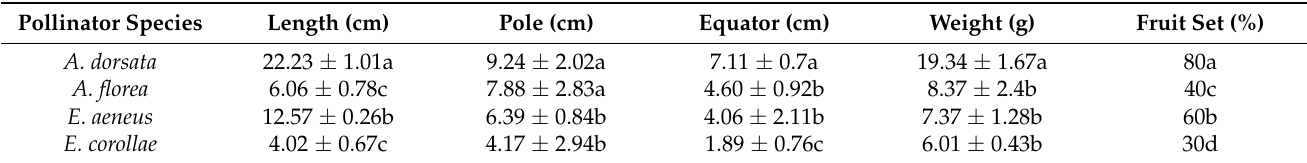
Table 3. Fruit length, pole, equator, weight, and fruit set resulting from single visits by the two honey bee species and two syrphid fly